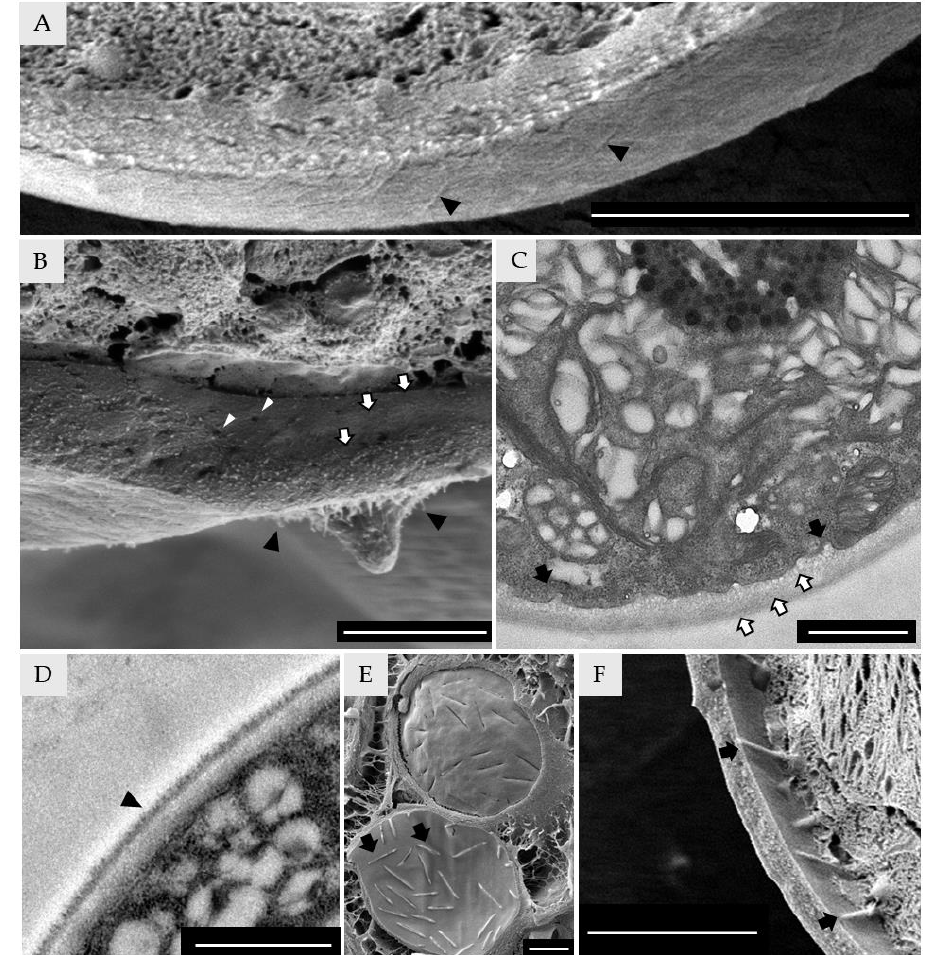
Figure 9. LTSEM ( A , B , E , F ) and TEM ( C , D ) of Trebouxia lynnae cell wall. ( A ) Cell wall depicting superficial fibers. ( B , C ) Cell wall depicting three layers, inner pores, and fibrils. ( D ) Fibrils on the surface of the cell wall. ( E , F ) Eisosomes. Cell wall layers are indicated by white arrows. Eisosomes are indicated by black arrows. Inner pores are indicated by white arrow heads. Fibrils are indicated by black arrowheads. Scale bars: ( A – F ) 1 µm.